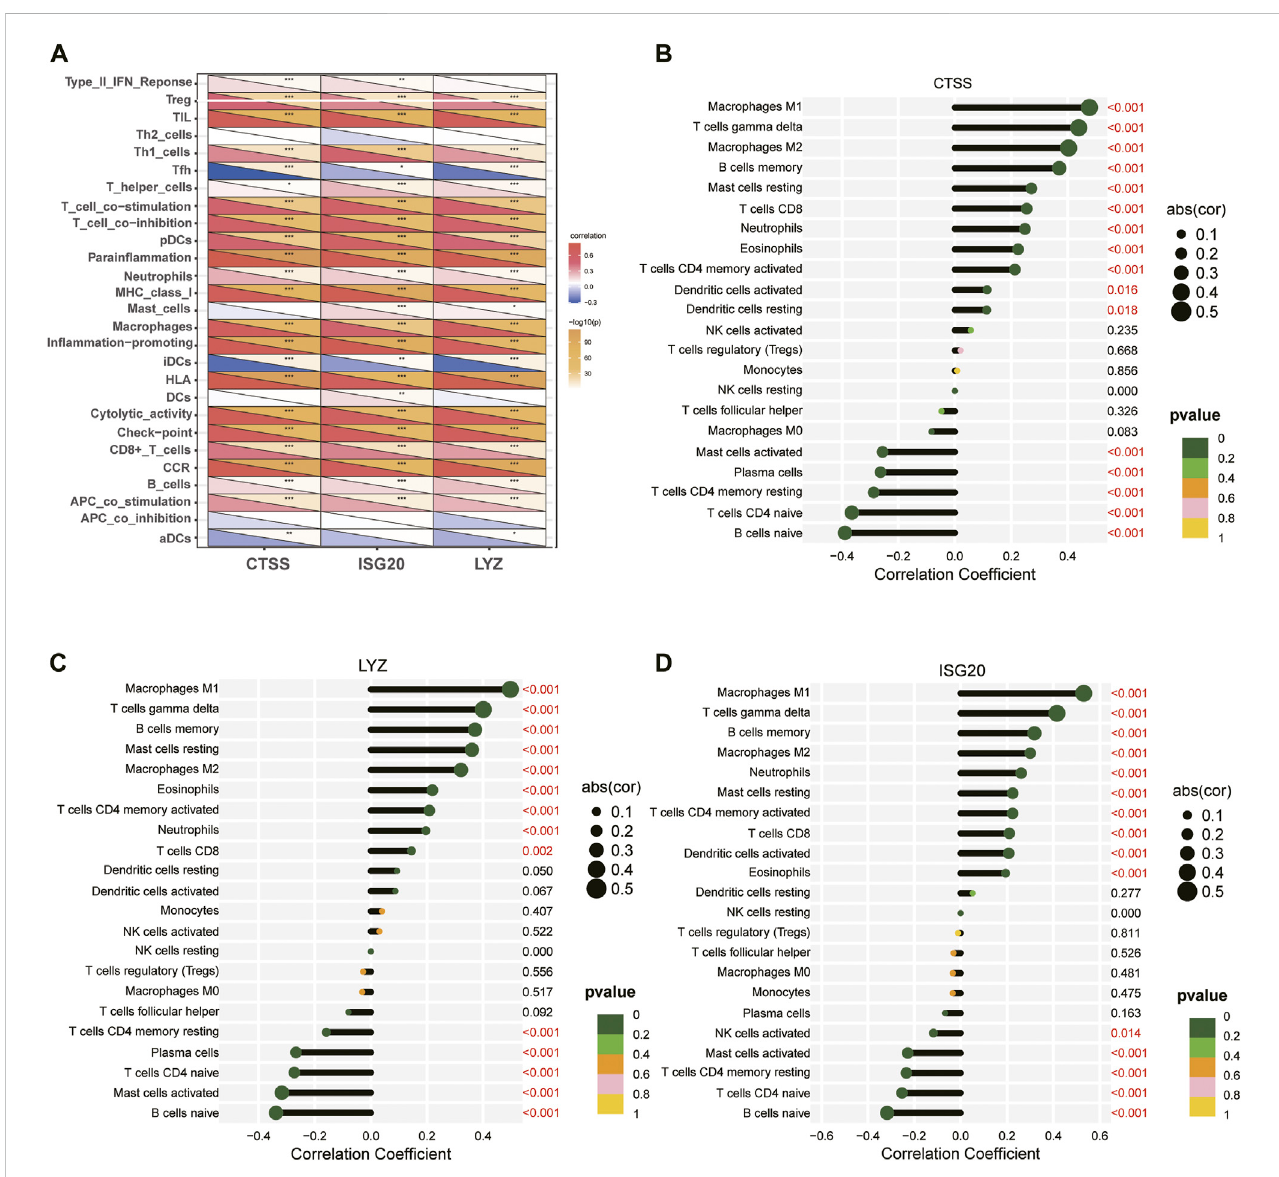
FIGURE 11 Relationship between three key diagnostic biomarkers and immune cell in fi ltration. (A) Visualization of immune cells or pathways in relation to three biomarkers by GSVA. (B – D) Correlation between immune cell in fi ltration and (B) CTSS, (C) LYZ, (D) ISG20 gene expression. *** p < 0.001; ** p < 0.01; and* p <